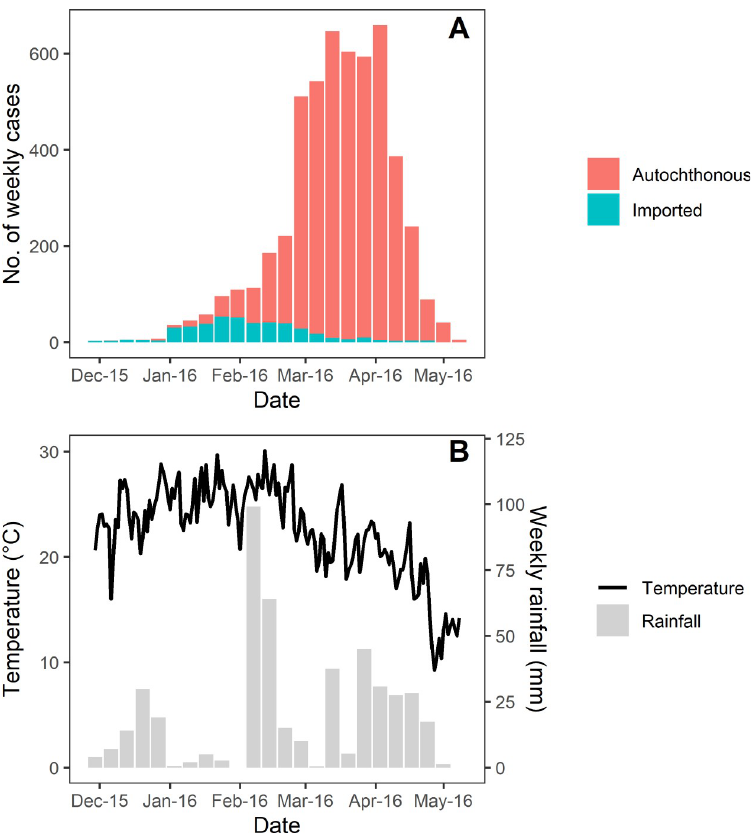
Fig 2. Overall dynamics of dengue transmission, temperature, and rainfall in Buenos Aires during the 2016 outbreak. A) Weekly cases of dengue according to date of onset of symptoms and origin of infection. B) Daily mean temperature (black line) and weekly rainfall (grey